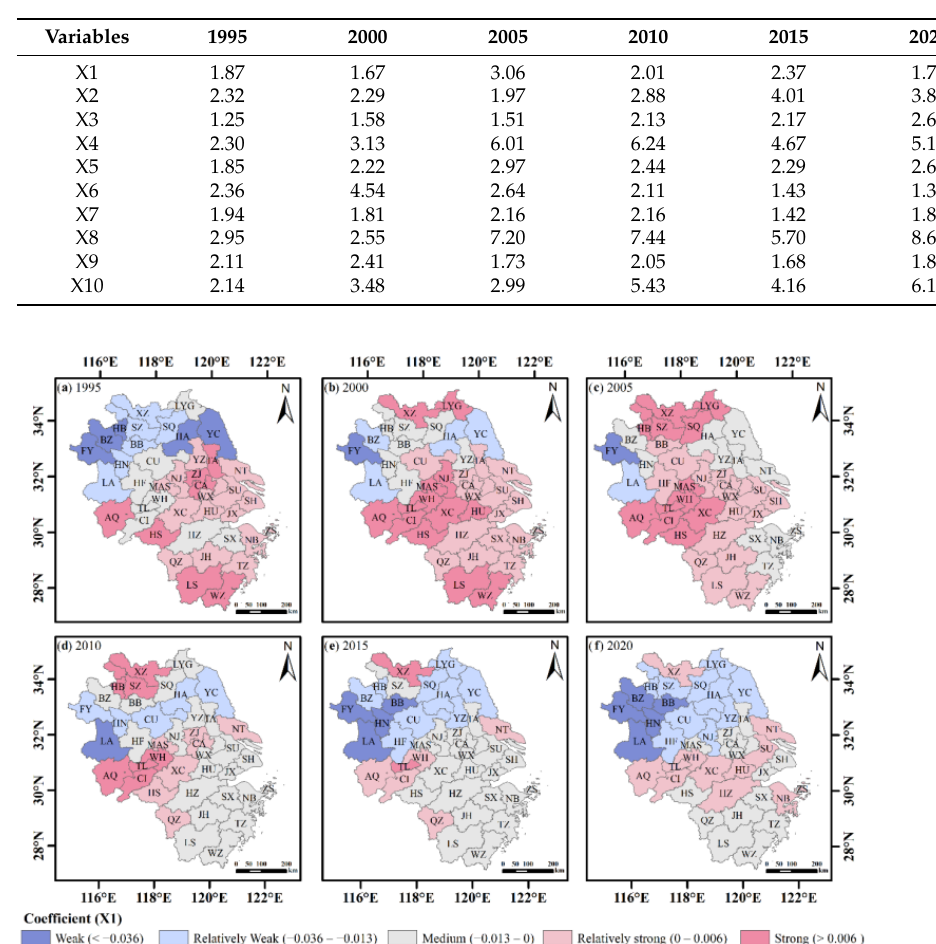
Figure A1. Spatial distribution of the regression coefficients of the urban development intensity.